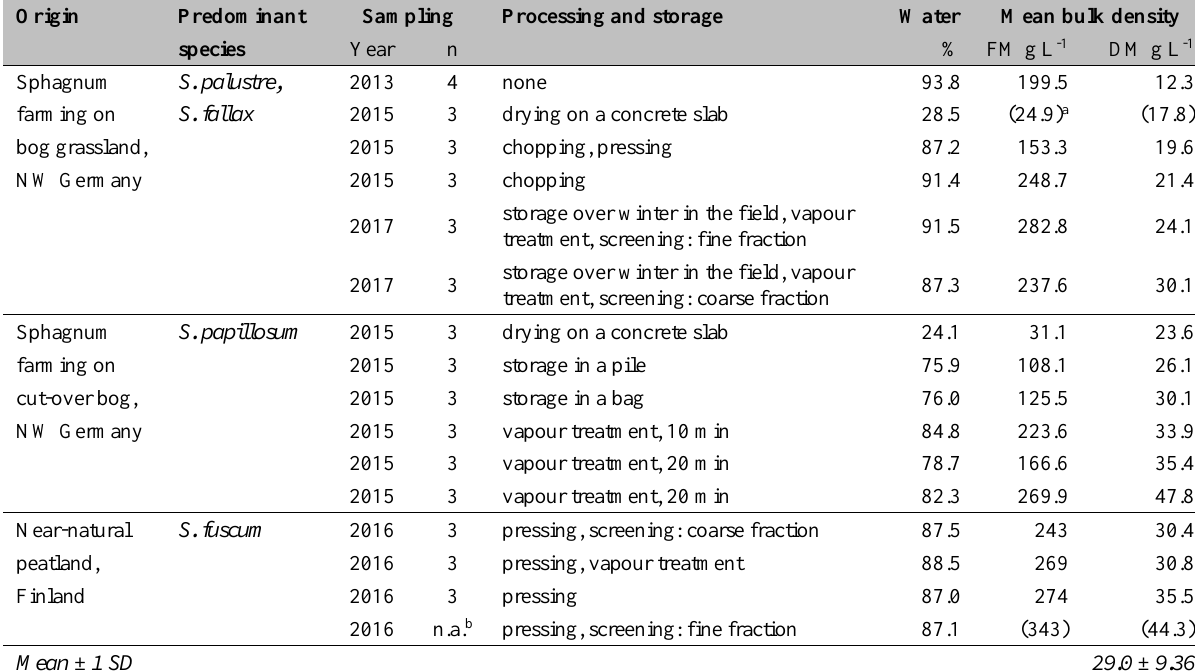
Table A3. Mean bulk density of fresh Sphagnum biomass (FM g L -1 ) according to EN 12580 and calculated dry mass bulk density (DM g L -1 ) in dependence of the water content.